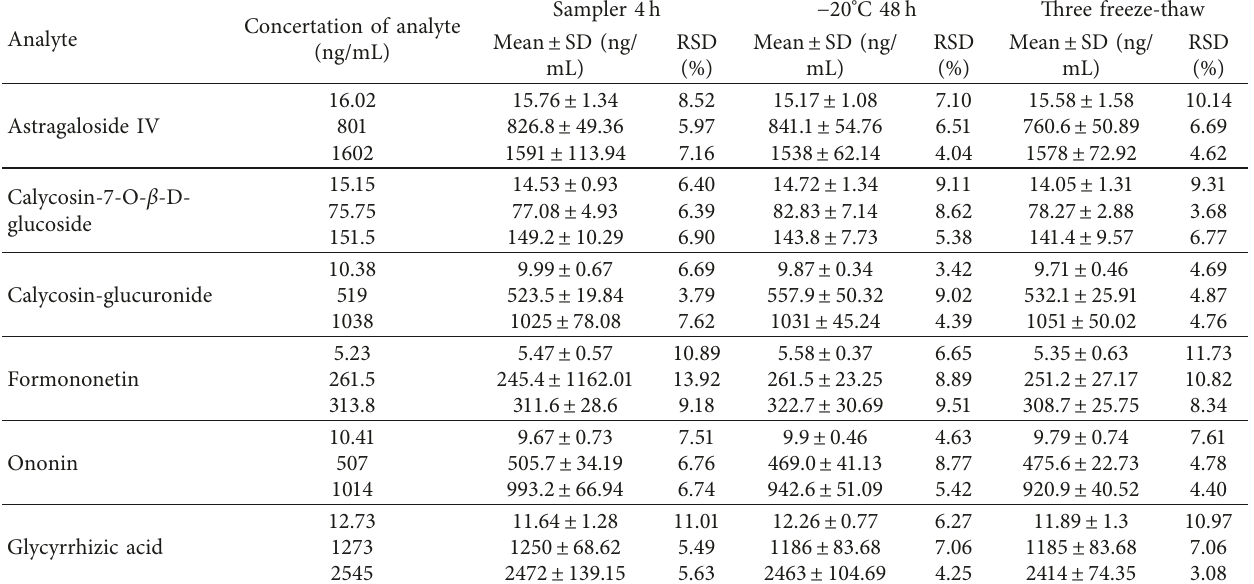
Table 5: Stability of six analytes in mouse plasma ( x ± SD, n �